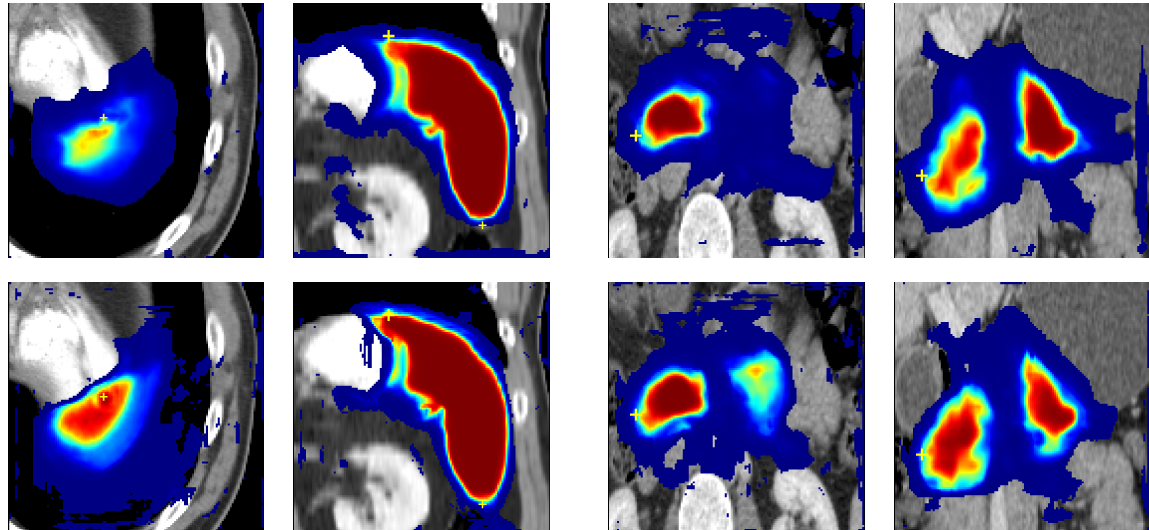
Figure 6. The impact of adding the point loss and point attention to our weakly supervised models. We show the results of the ( top ): weak. sup. dextr3D (w RW) Dice ; and ( bottom ): weak. sup. dextr3D (w RW) Dice + Point loss + Point Attn settings. Examples from the MSD-Spleen ( left ) and MO-Pancreas ( right ) datasets are shown, respectively. The clicked extreme points are shown by a yellow cross. Best viewed in color. The predictions learned together with the point loss do lie markedly closer to the clicked point locations.